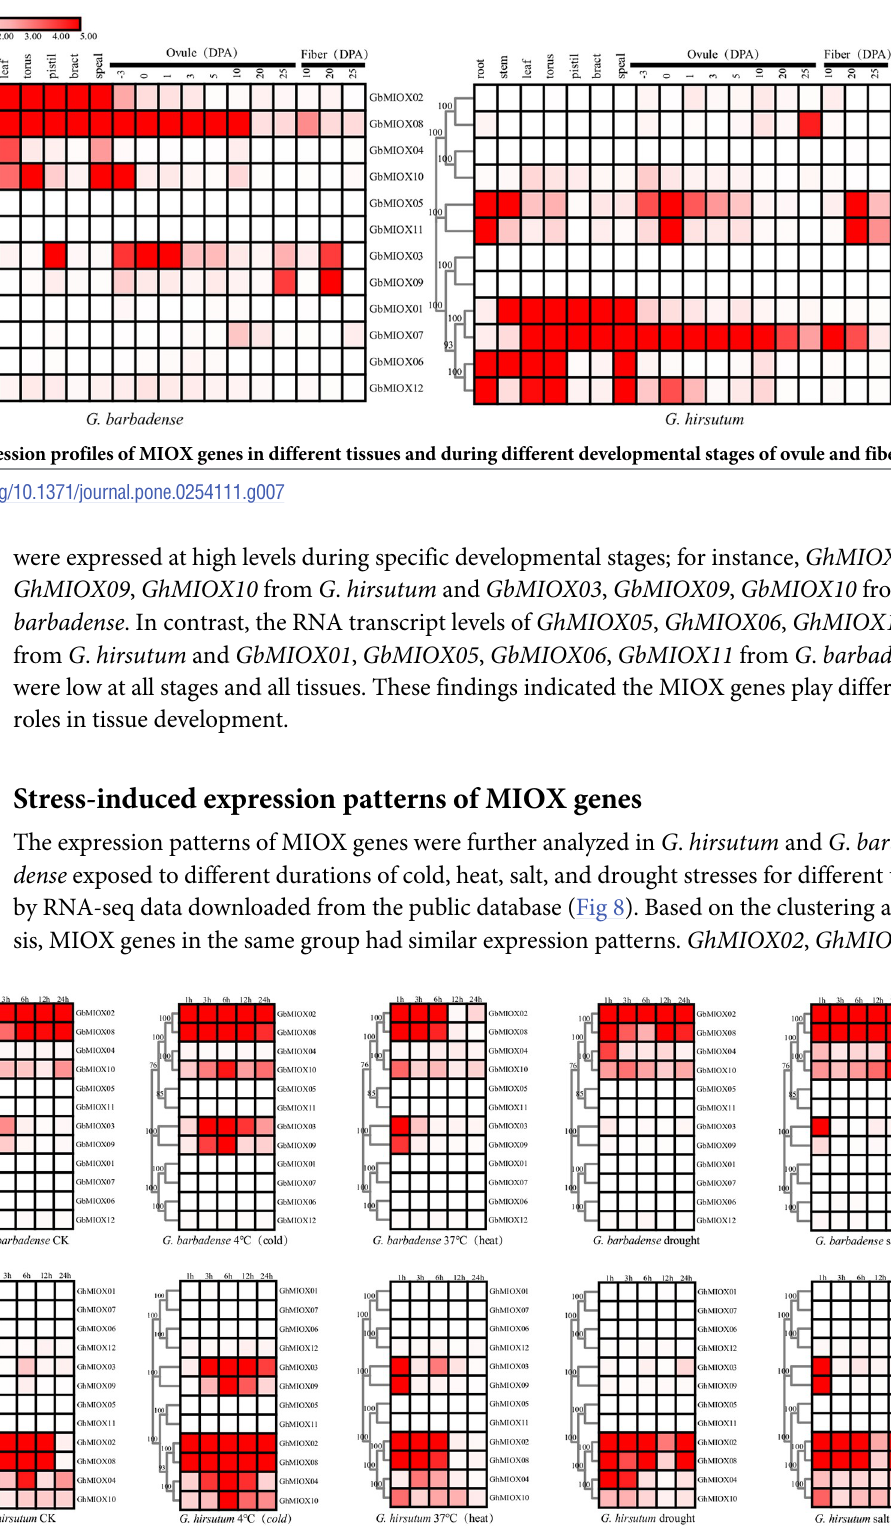
Fig 8. Expression profiles of the MIOX genes in response to different